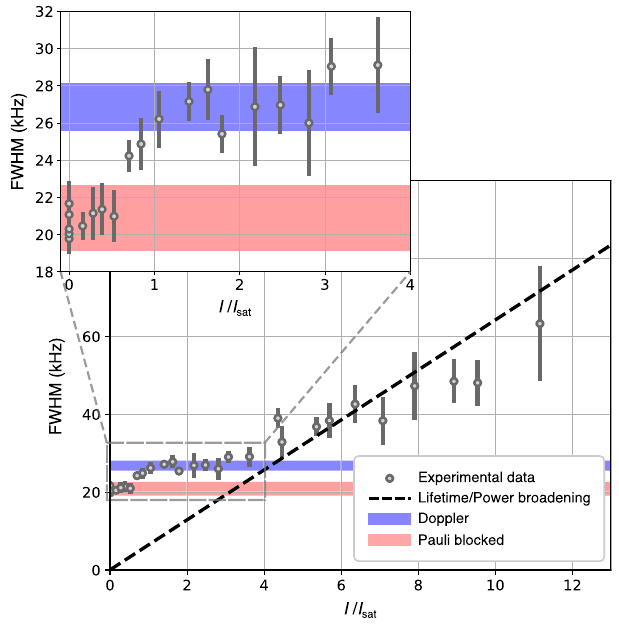
Fig. 4 | Dependence of the FWHM on the depumper intensity. The observed FWHM(graydots)isshownasafunctionofdepumperintensityexpressedinterms ofthesaturationintensityasde fi nedinthetextandtheSupplementaryNote5.The errorbars on these points represent the error on the FWHM obtained from fi tting Gaussian pro fi les to the measured line pro fi les. The regimes where narrowing happens as a consequence of Pauliblocking and wherethe pro fi le isfully Doppler- dominated are seen as the fi rst and second plateau respectively. Their expected values from the spread of the parameters of the Fermi gases are displayed as red and blue areas respectively. The dashed black line shows the expected FWHM based on only lifetime and power broadening obtained from numerically solving the optical Bloch equations describing the evolution of a four level system for a single atom. The inset provides a zoom of the Pauli blocking and Doppler broa- dened